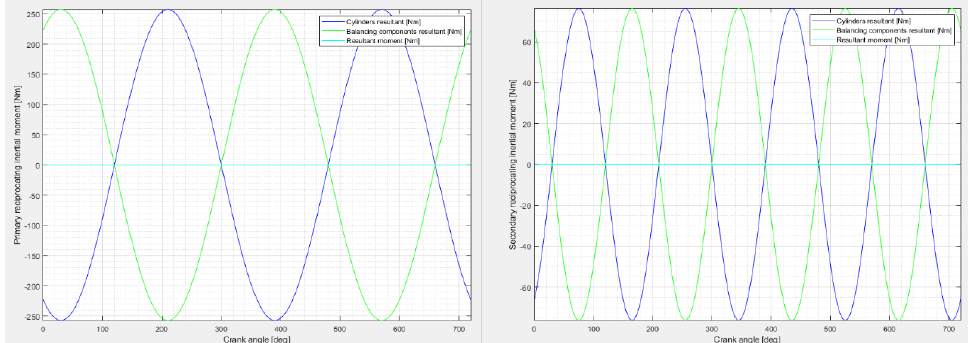
Figure 13. Primary ( left ) and secondary ( right ) reciprocating moments for a 3 cylinder in-line